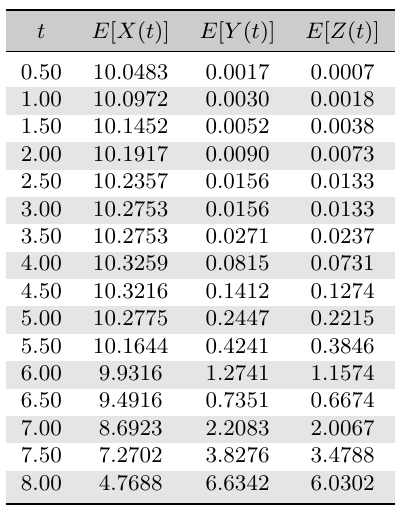
Table 1: E [ X ( t )] , E [ Y ( t )] and E [ Z ( t )] versus t for α = 100.0, λ = 0.20, µ =